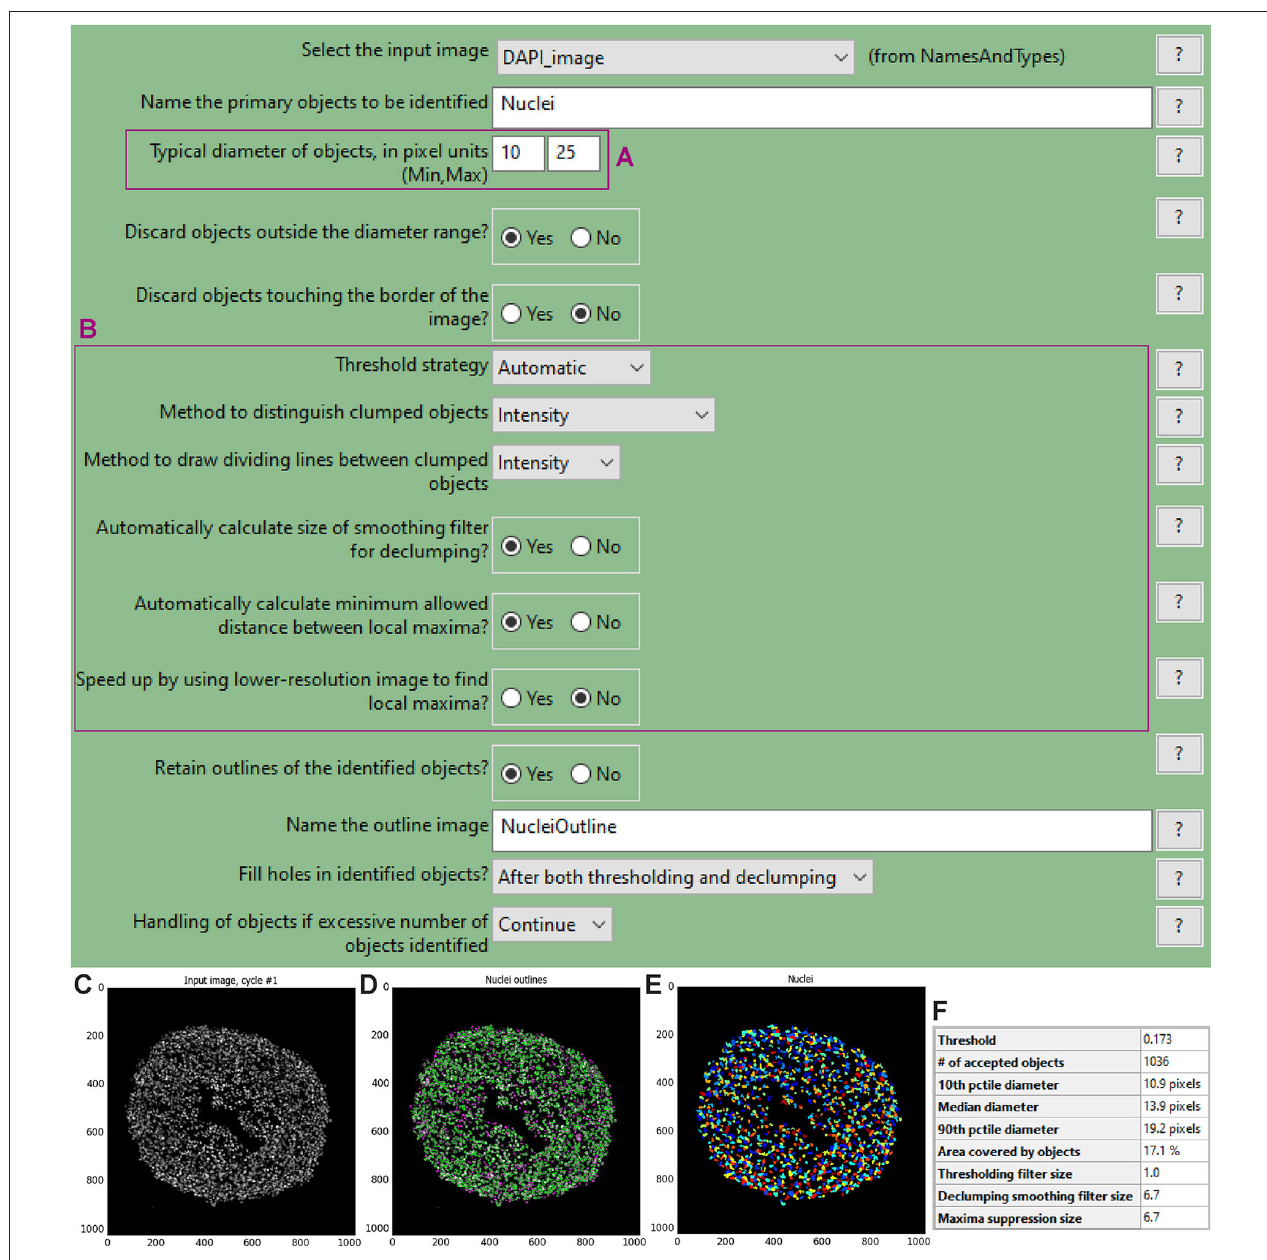
FIGURE 4 | “IdentifyPrimaryObjects” module window and test mode results. The “IdentifyPrimaryObjects” module interface shows the parameters that can be adjusted to modify object identification accuracy such as the objects diameter range (A) . Other parameters include the threshold strategy, which affects the decision of whether each pixel will be considered a region of interest or background, and segmentation via the method to distinguish clumped objects and via the minimum allowed distance between local maxima (B) . For each steps of the pipeline a window displays the raw, original image (C) , the raw image overlaid with the coloured outlines of the identified objects and (D) the identified objects shown as a colour image where connected pixels that belong to the same object are assigned the same colour. For image (D) each object is assigned one of three colours: green for acceptable objects that passed all criteria, magenta for objects discarded based on size and yellow for objects discarded due to touching the image border. For image (E) the assigned colours are arbitrary. The windows also show a table with some of the settings selected by the user, as well as those calculated by the module in order to produce the objects shown (F) .